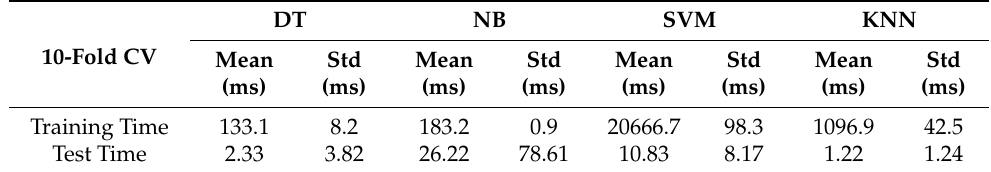
Table 7. Time of feature extraction, training and test operations for DT, NB, SVM and KNN.